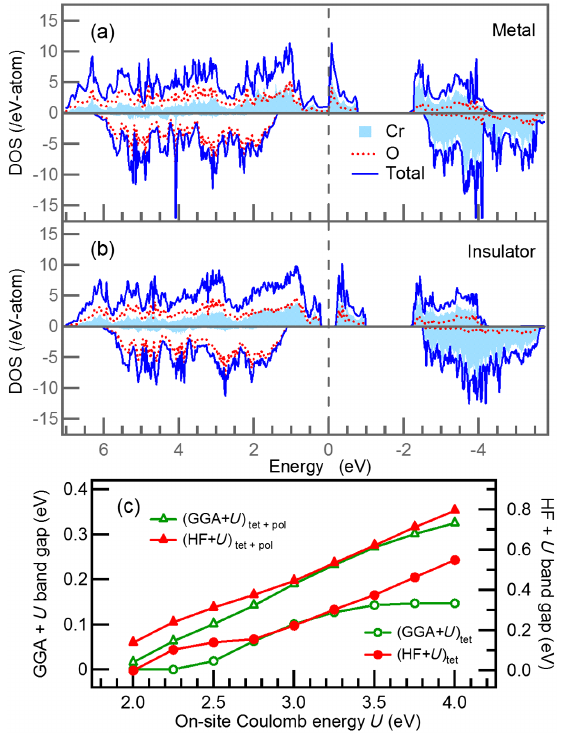
FIG. 3. DOS and band gap from first-principles calculations. structure. (b) Introducing a structural distortion in the presence of U opens up a gap at zero energy (E ) (see text for details). F for different values of U , assuming a structural tetramerization (tet) without and with polaronic (pol)